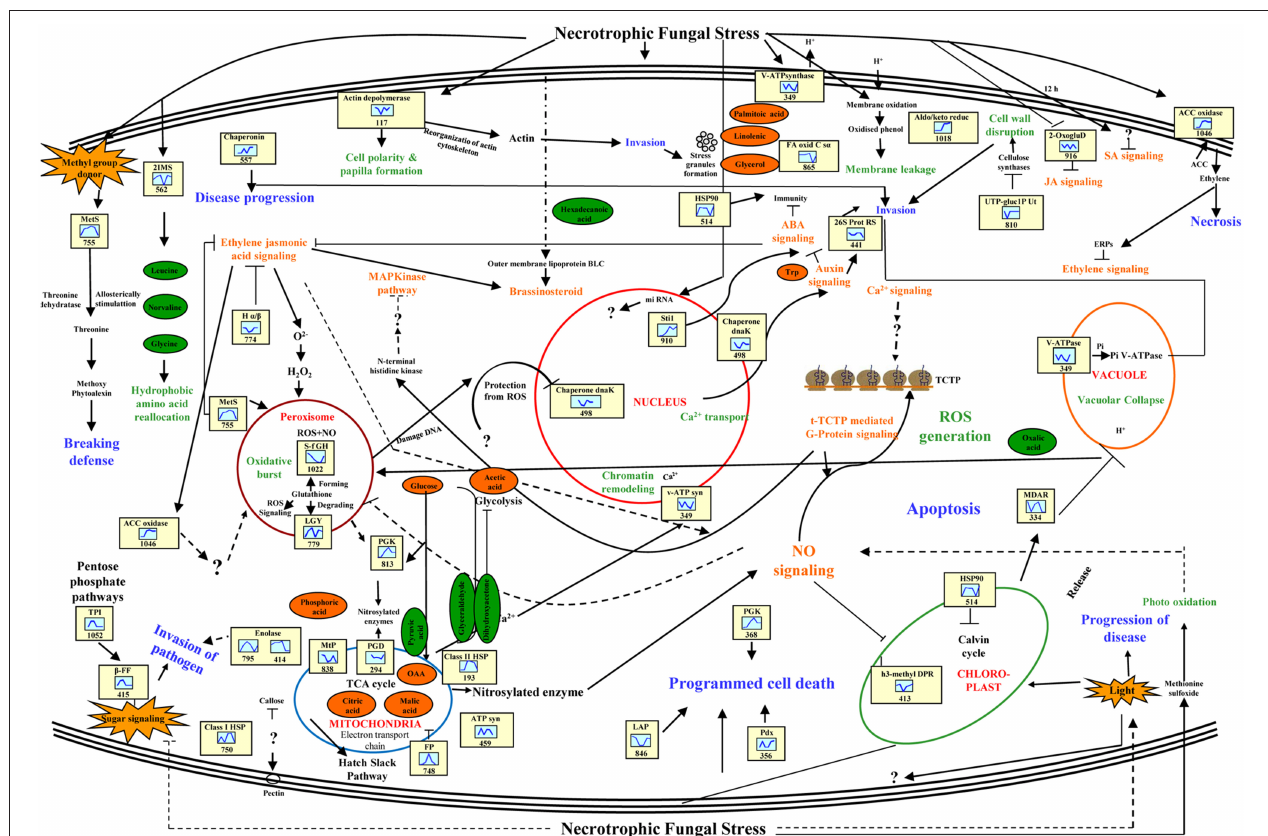
FIGURE 7 | Pathway involved in crosstalk among diverse pathways putatively functional in disease responses of Tomato- Scleretonia interaction. Proteins identified in this study are indicated in the yellow boxes. Green circles represent metabolites up-regulated, and orange circles indicate down-regulated metabolites. The graphs are representative of the abundance pattern of individual protein, and the number shown below indicates the protein identification number. LEA, late embryogenesis abundant protein; S-AHC, S- adenosylhomocysteinase; APx, PGK, phosphoglycerate kinase; PP, pyrophosphatase; NO, nitric oxide; MtP, mitochondrial peptidase; C-I HSP, C-II HSP, GST, glutathione S-transferase; ACC, ROS, reactive oxygen species; β -FF, beta-fructofuranosidase; GAPDH, MDH, IMS, 2-isopropyl malate synthase; CA, carbonic anhydrase; FP, KARI, ketole acid reductase isomaerase; PGD, phosphoglycerate dehydrogenase; PGK, Prx, LGY,